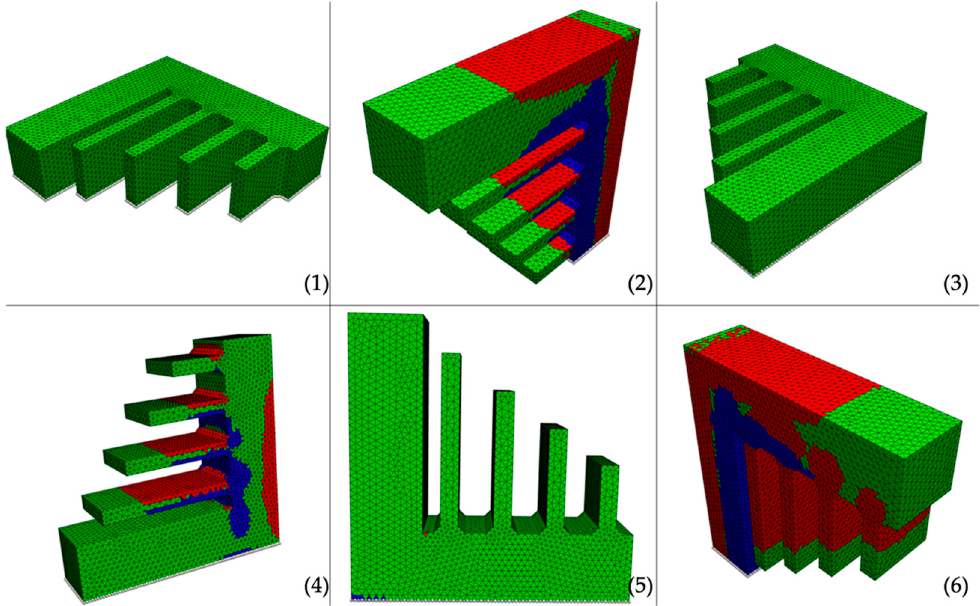
Figure 6. Failure-plot of the debinding simulation of the staircase. ( 1 )–( 6 ) denote the number of the orientation, white dots represent the bottom plane, red areas indicate failure due to tension, and blue areas indicate failure due to compression.